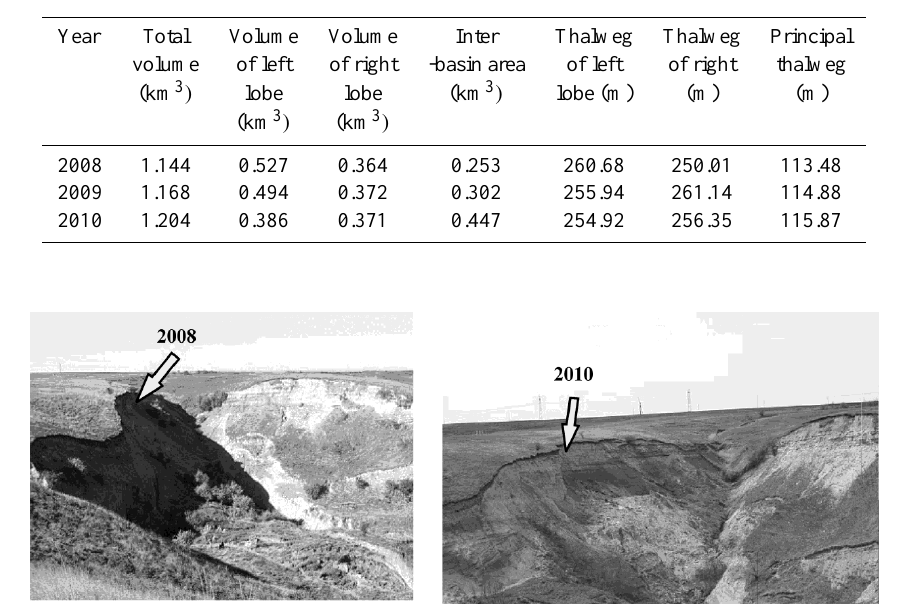
Table 1. Morphometric characteristics of the Cucuteni-Baiceni gully.